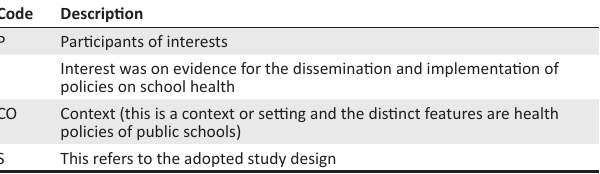
TABLE 1: Participants, Interest, Context, Study design with elements of the review